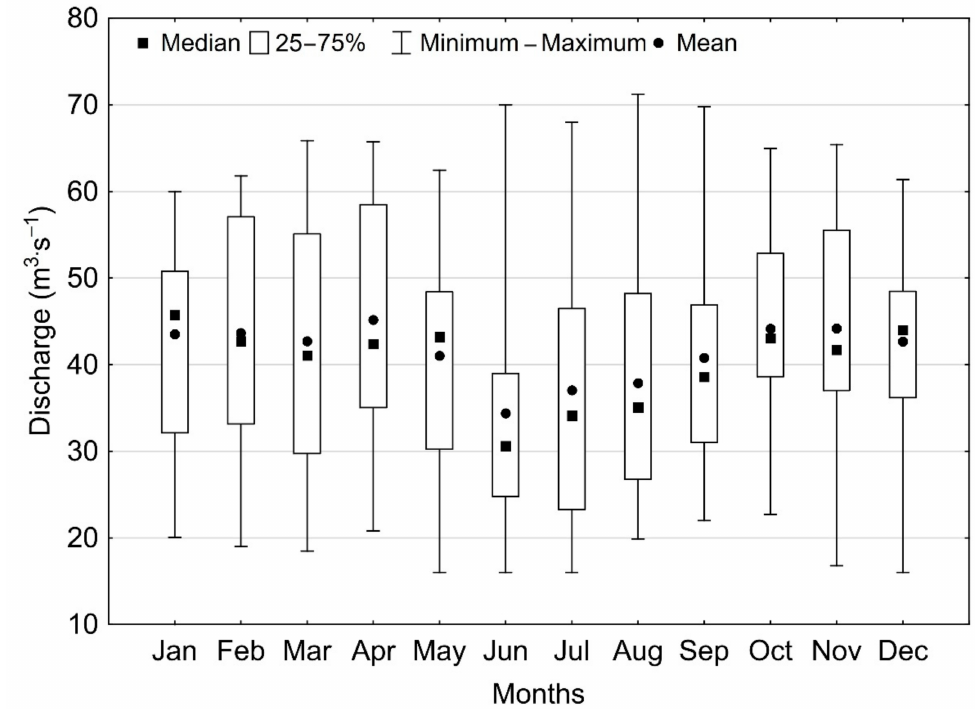
Figure 6. Mean monthly water flows through the hydropower plant on the Jeziorsko reservoir in the period